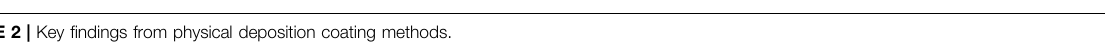
TABLE 2 | Key fi ndings from physical deposition coating methods. Surface modi fi cation method Key fi